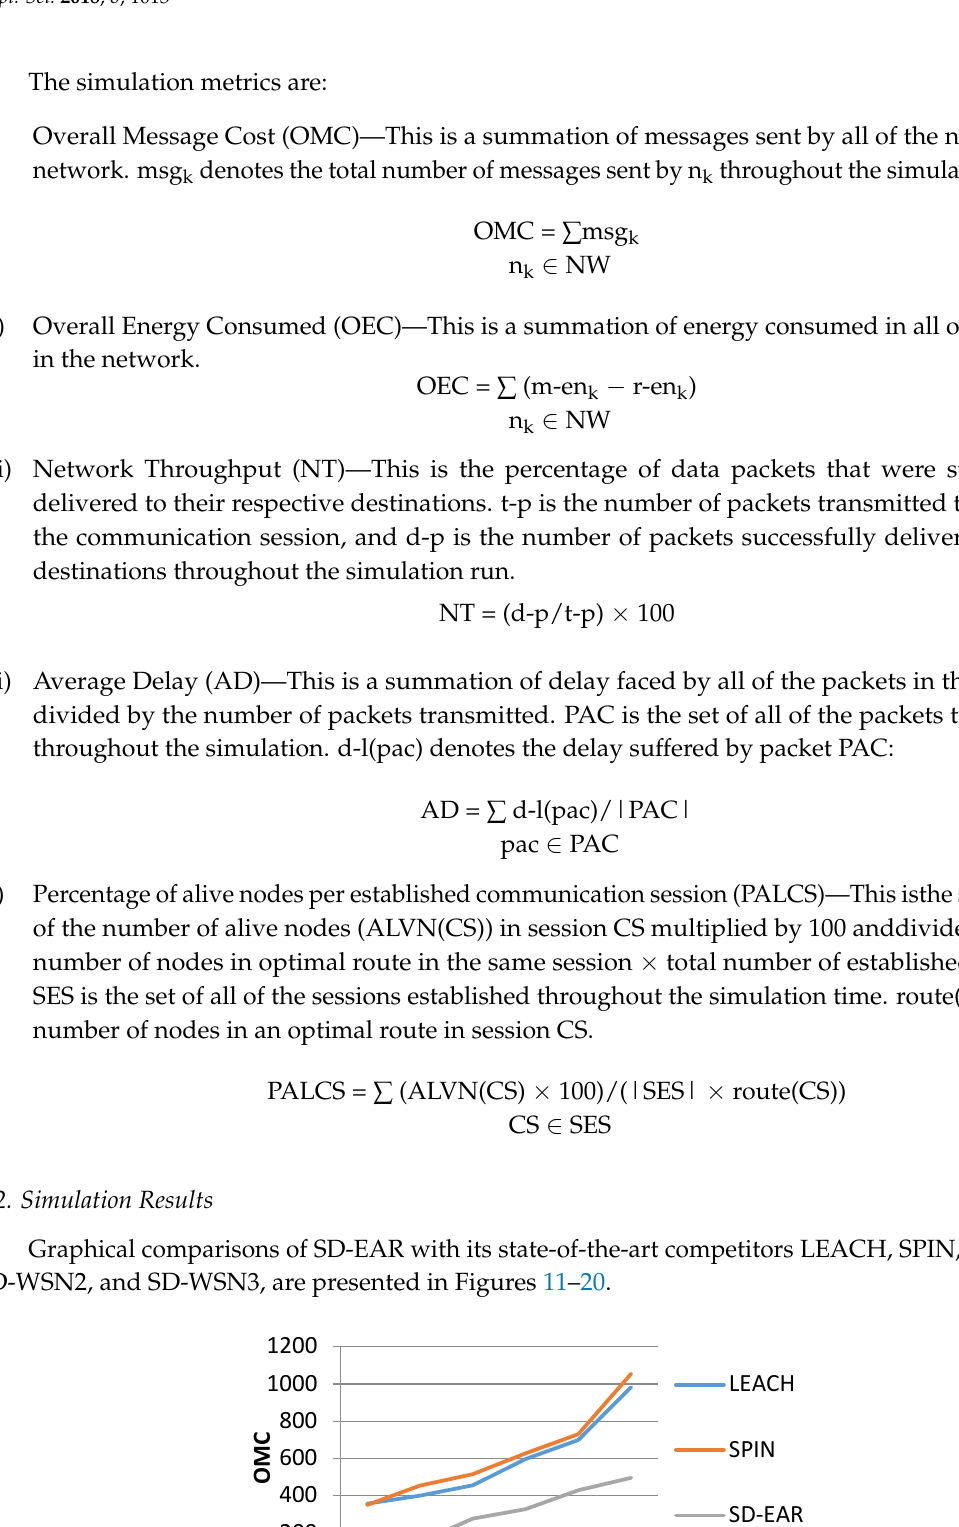
Figure 12. Overall Energy Consumed (OEC) vs. number of nodes.